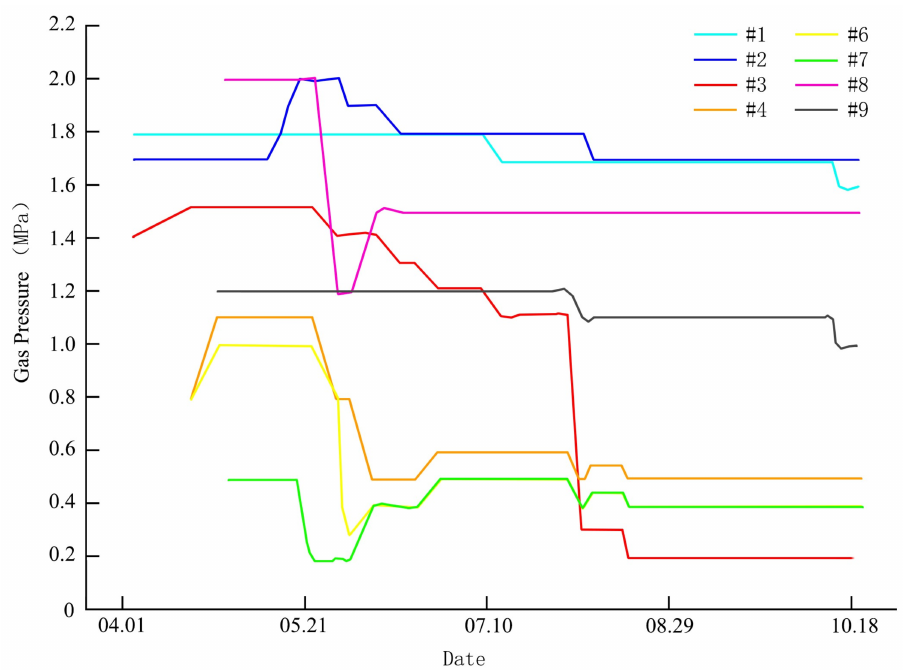
Figure 17. Pressure change curve of inspection drill holes.5.2.2. Extraction Experiment.